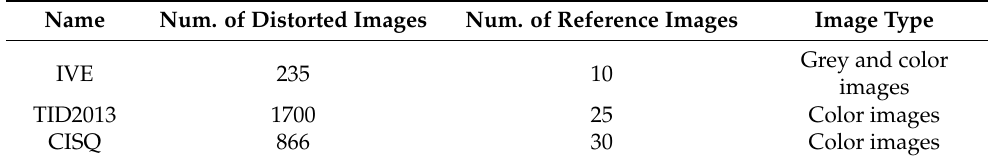
Table 1. Image databases for training the